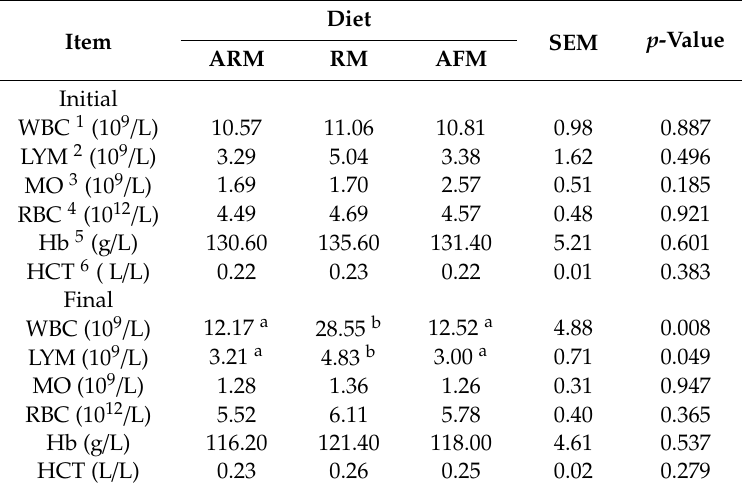
Table 7. Hematological parameters of dairy calves fed di ff erent types of